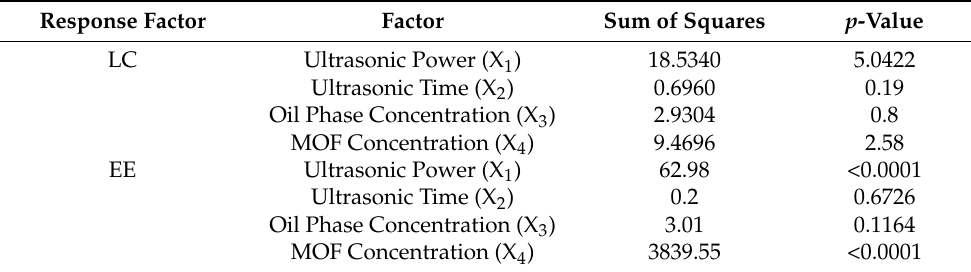
Table 3. Analysis of variances for preparation of the delivery system by a joint test.